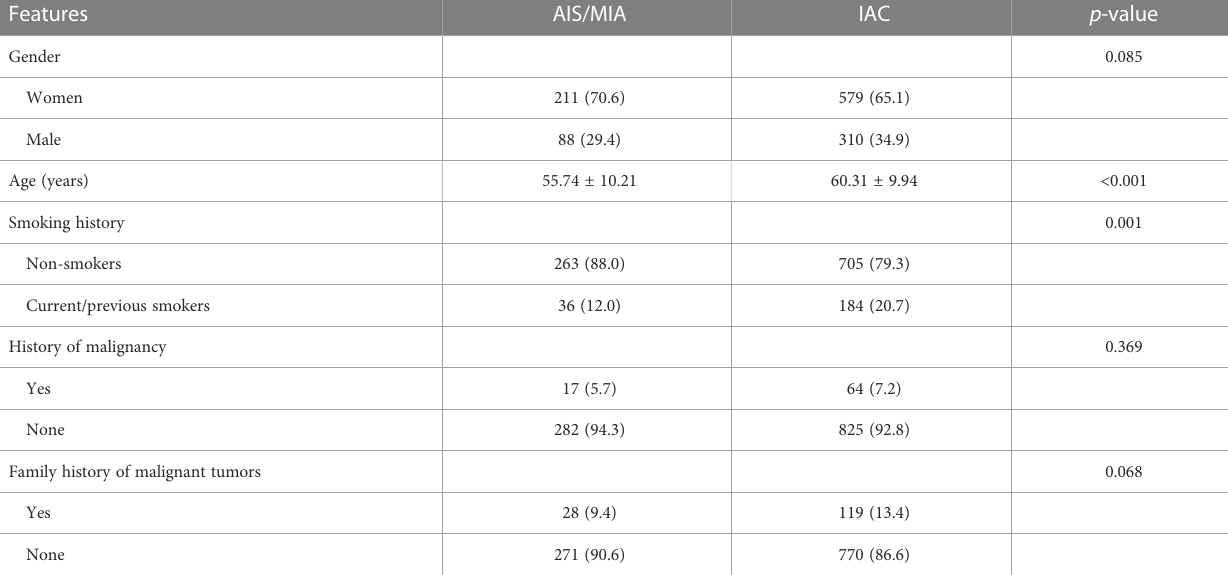
TABLE 1 Comparison of clinical information of AIS/MIA and IAC in 1,188 cases of PSNs.